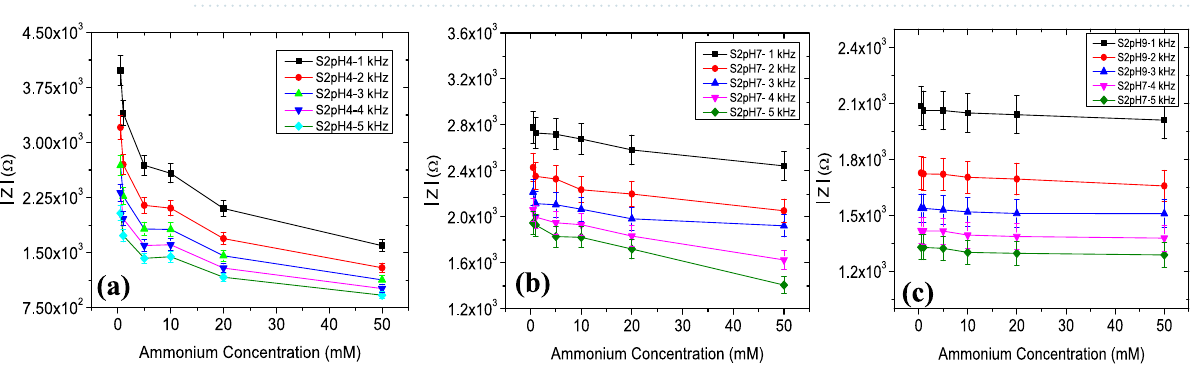
Figure 4. Impedance magnitude (Ω) versus NH 4+ ion concentration (0.5–50 mM) response of the sensor S1 in the ( a ) acid, ( b ) neutral and ( c ) alkaline sample conditions.